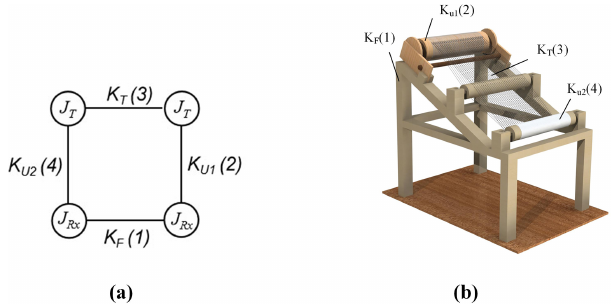
Figure 11. Chains and simulation drawing of the cloth-rolling